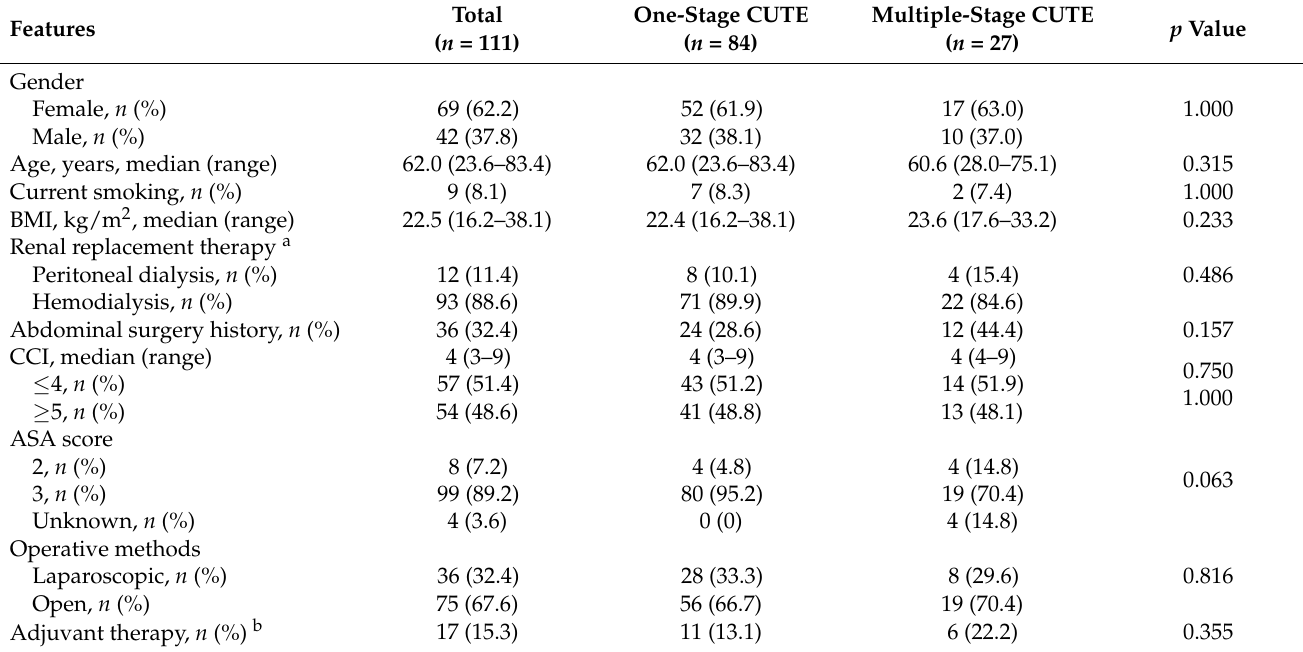
Table 1. Characteristics of dialysis patients undergoing CUTE.